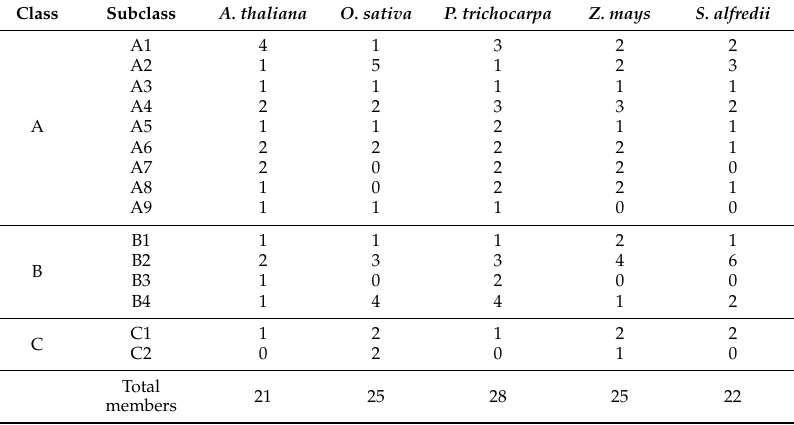
Figure 1. Phylogeny and distribution of heat shock transcription factor (Hsf) proteins. Phylogenetic tree of Hsf proteins from A. thaliana , O. sativa , and S.alfredii . The tree was generated with MEGA 6.0 software using the neighbor-joining (NJ) method. Hsfs in S.alfredii were labeled with the red color. Table 2. Members of the Hsfs classes and subclasses in different plant